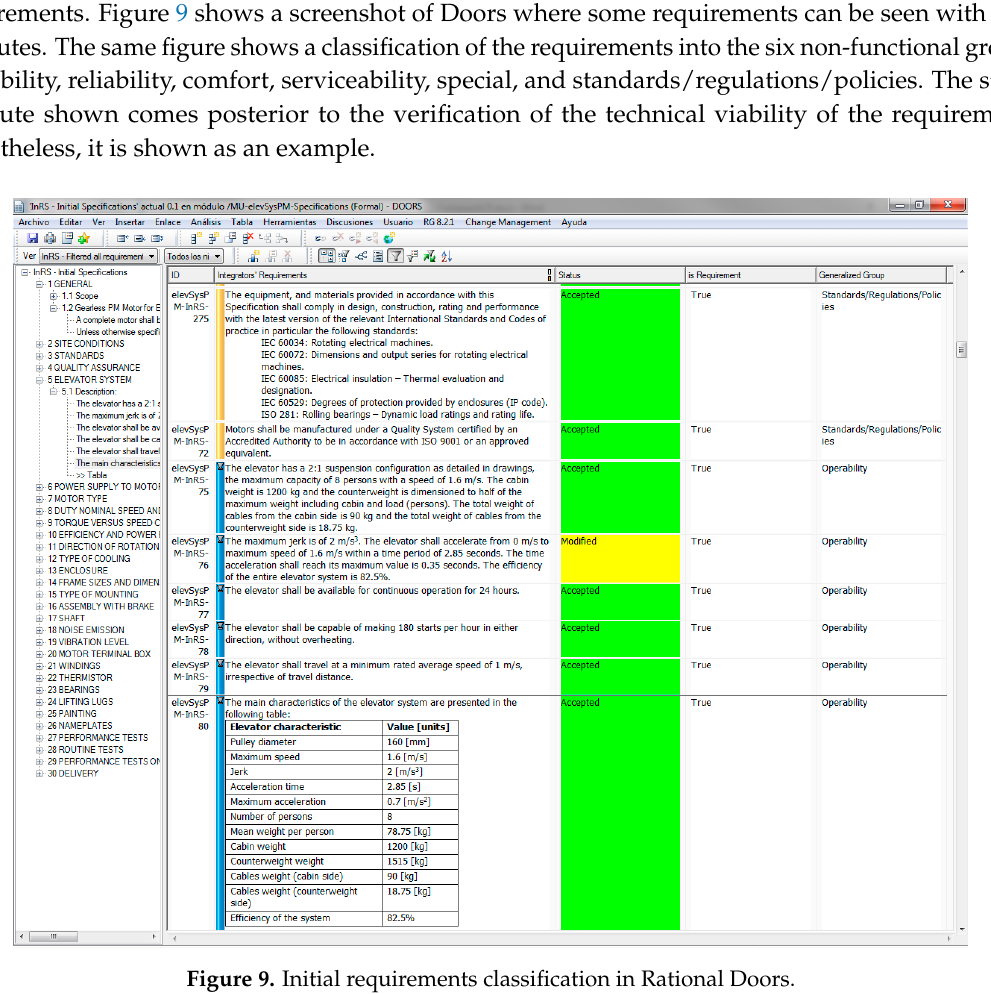
Figure 9. Initial requirements classification in Rational Doors.